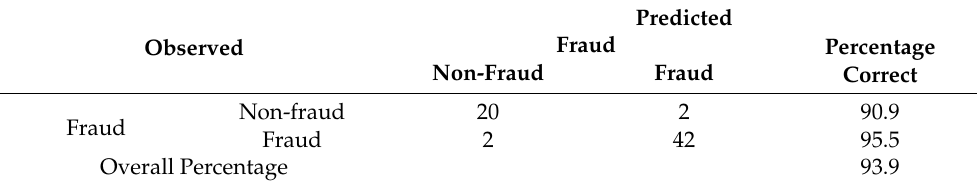
Table 5. Classification Table for the multivariate binary regression.